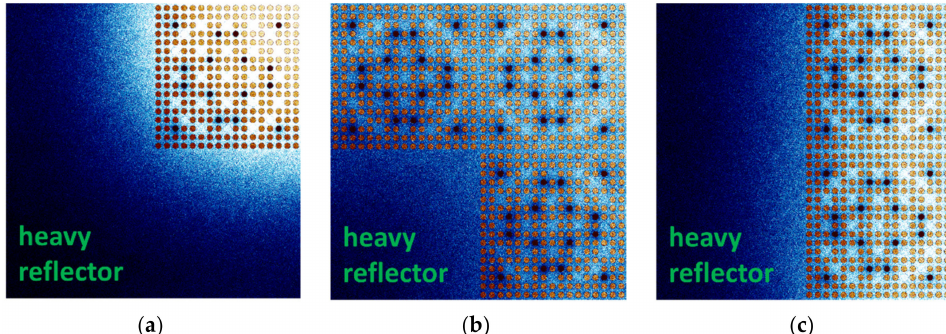
Figure 8. Simulated normalised thermal flux (in “cold” shades of blue) and fission rate (in “hot” shades of red and yellow, Gd-bearing rods in dark red) radial distribution in fuel / reflector ( a ) 1 + 3 super cell; ( b ) 3 + 1 supercell; ( c ) 2 + 2 super cell (using reflective boundary conditions).